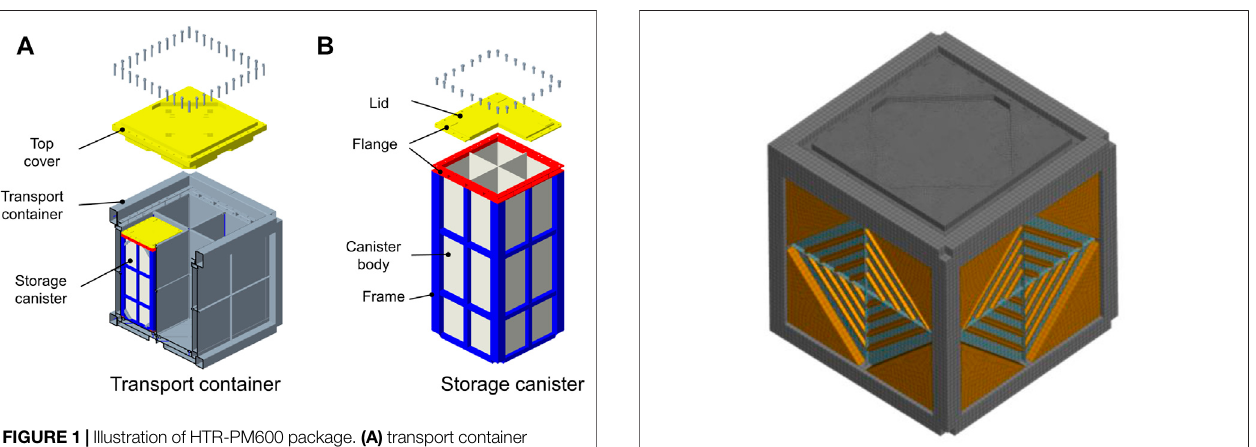
FIGURE 2 | FE model of